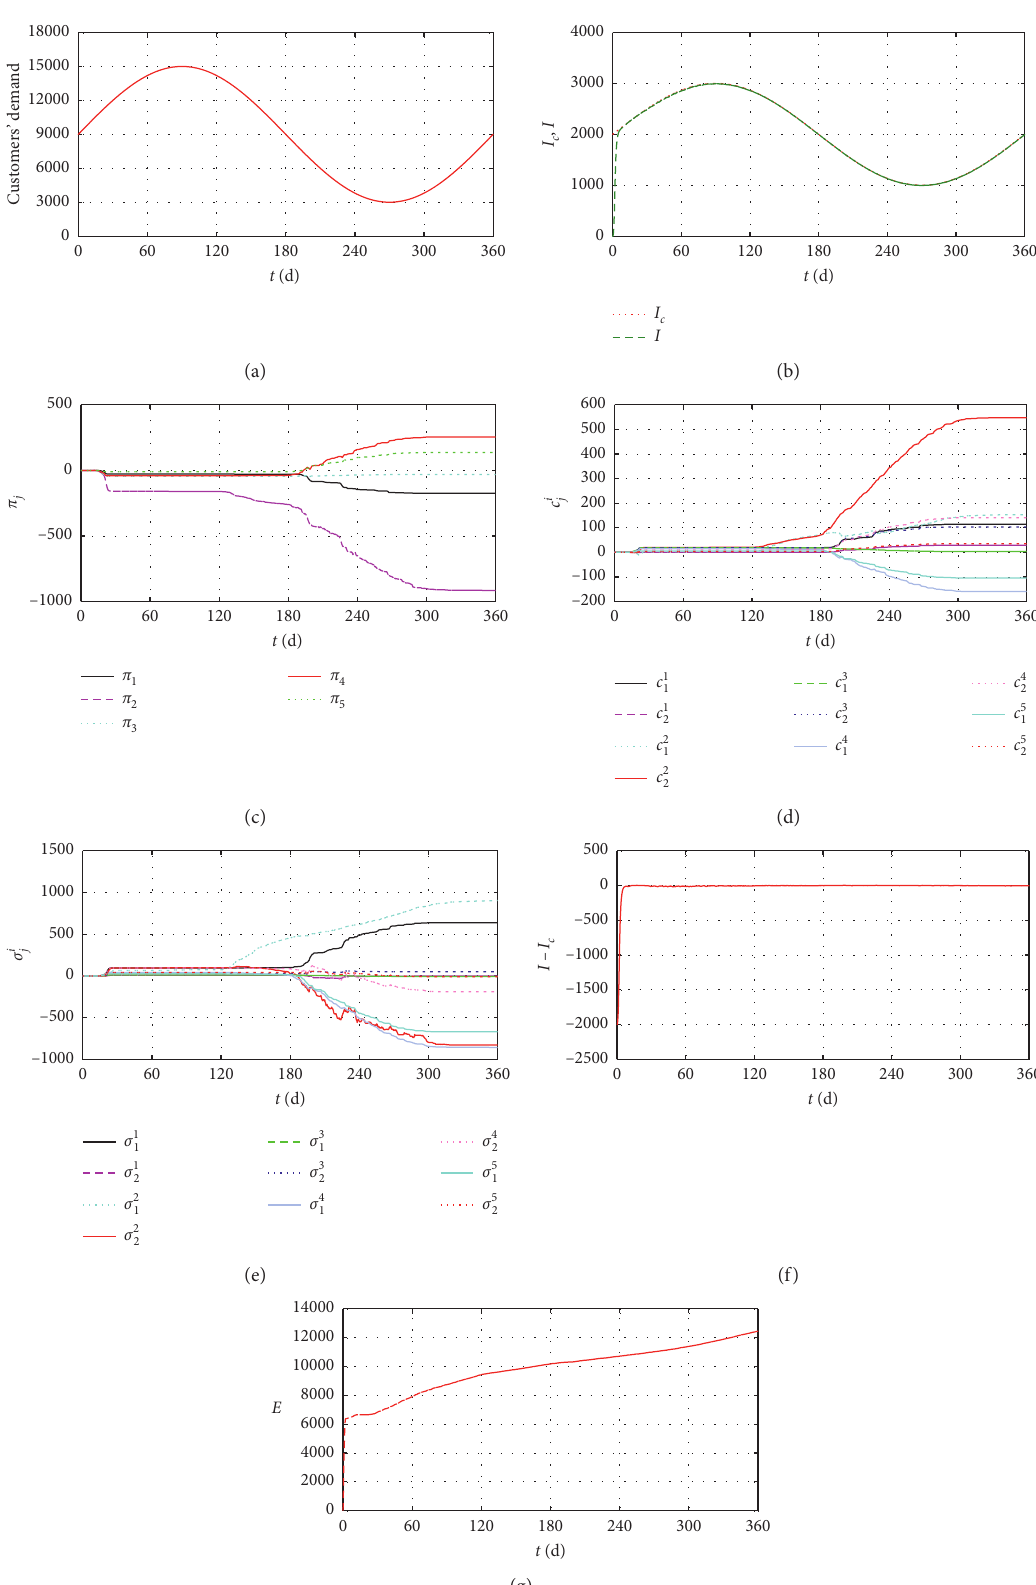
Figure 4: Simulation results under sine demand. (a) Customers’ demand, (b) Inventory curves, (c) Curves of adaptive parameter π (d) Curves of adaptive parameter c i j . (e) Curves of adaptive parameter σ i j . (f) Error curve of I − I c . (g) Curve of E